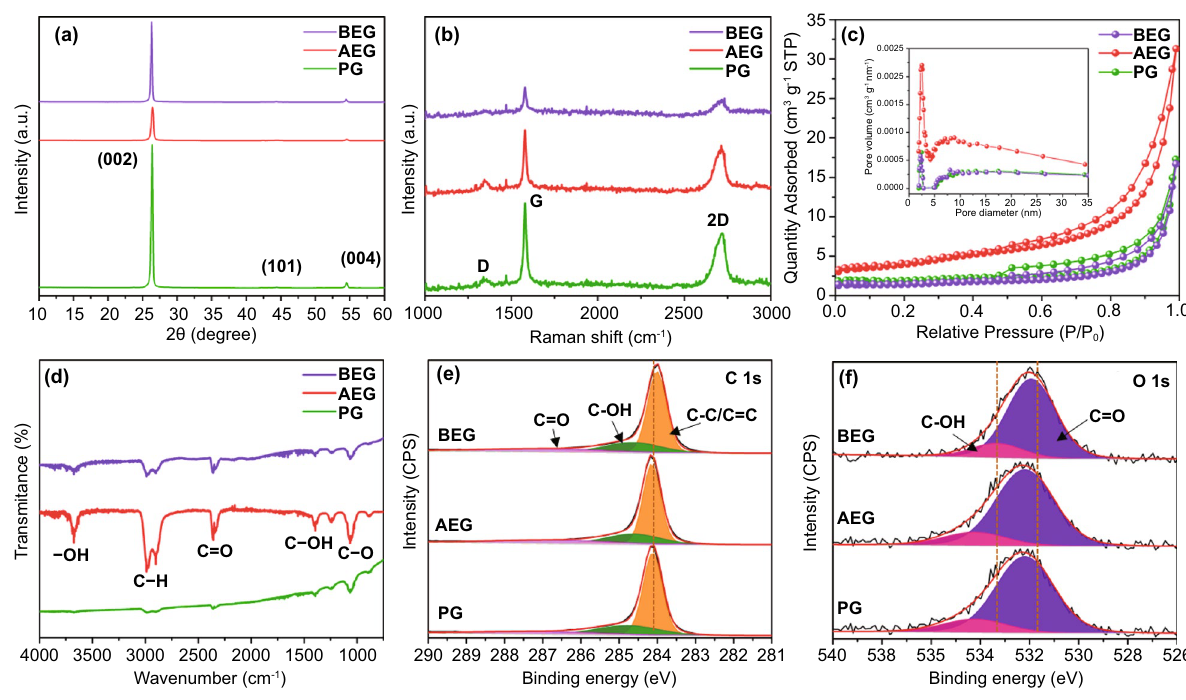
Fig. 3 a XRD pattern, b Raman spectra, c BET isotherm curves (inset; BJH pore size distribution), and d FTIR spectra for PG, AEG, and BEG samples. The XPS profiles of e C 1 s signal and f O 1 s signal for PG, AEG, and BEG